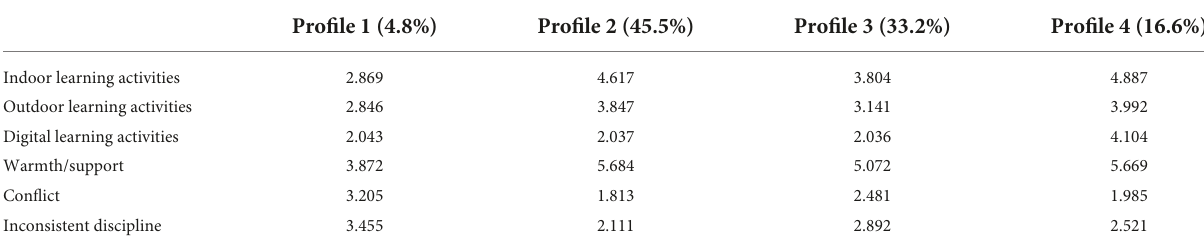
TABLE 4 Classification of home learning environment (HLE) profiles based on their most likely latent class pattern in regard to home learning environment questionnaire (HLEQ)